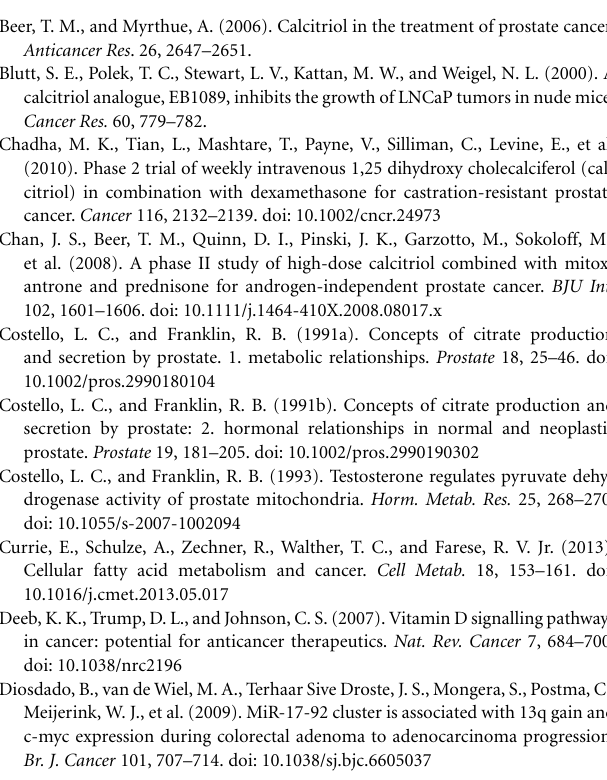
membrane synthesis, which prevents cancer cell proliferation. In addition, VDR and AR repress c-Myc levels and associated metabolic reprogramming to maintain prostate cancer cells in a more differentiated state. (dashed line: transcriptional regulation; green: inhibition; magenta: